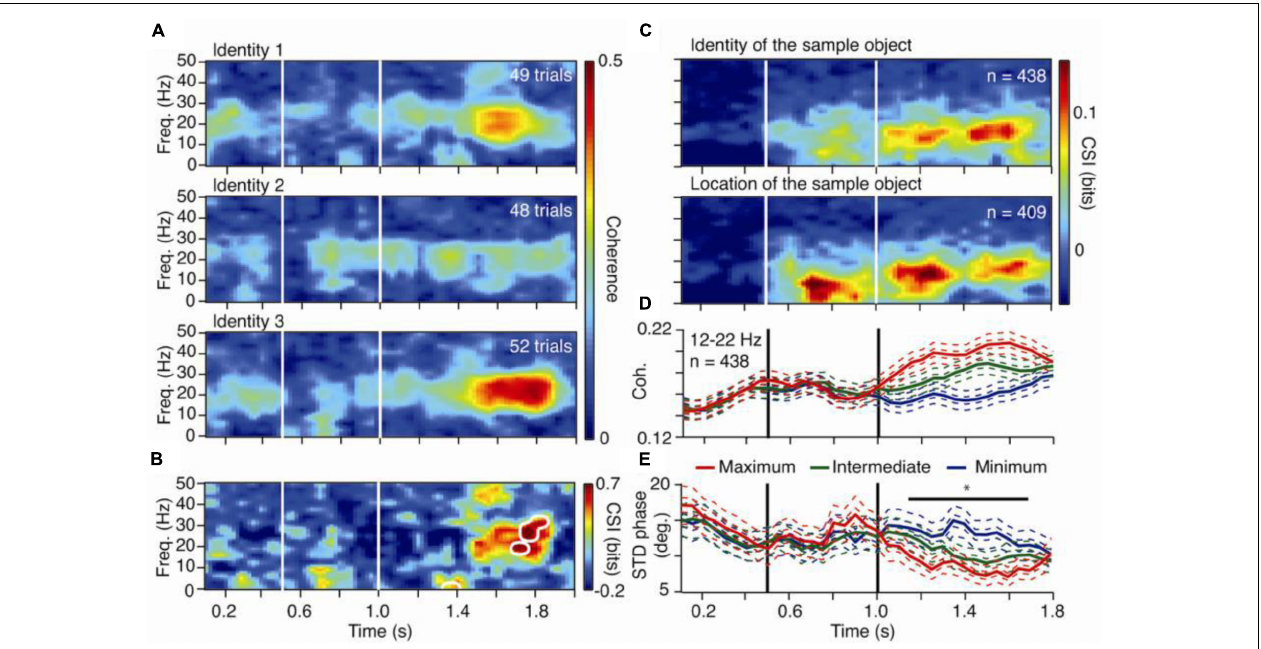
FIGURE 2 | Content specific fronto-parietal synchronization during working memory in the macaque monkey. (A) Time-frequency coherence spectra for an LFP pair for three sample objects presented at one screen location. (B) Coherence selectivity index as a function of time and frequency [CSI(t,f)] for the same pair showing significant selectivity (significance threshold at p < 0.02 indicated by white contours) during the delay period. (C) Median value of [CSI(t,f)] for LFP pairs showing selectivity for the sample identity (upper) and location (lower) during the delay. (D) Mean rank-ordered coherence (+/– SEM) in the 12–22 Hz band for the same identity selective pairs as in the upper plot of (C) . (E) Mean standard deviation of the relative phase (+/– SEM) in the 12–22 Hz band for the same identity selective pairs as in the upper plot of (C) . In plots (D,E) , the two SEMs were calculated with the number of pairs or sessions as the degree of